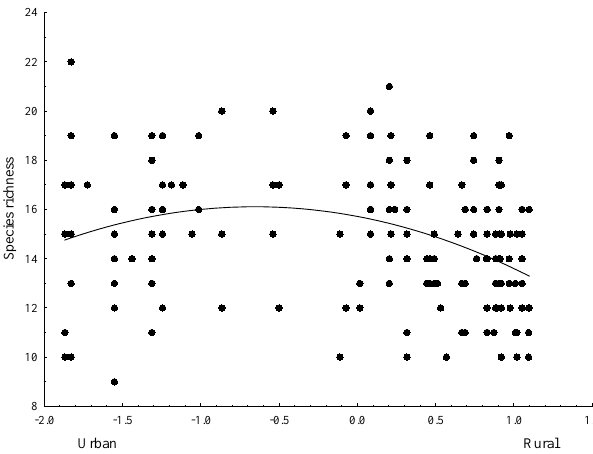
Figure 2. Non-linear principal component analysis regression showing the relationship between bird species richness (recorded at each point count station) and rural–urban gradient associated to the Factor 1 obtained from PCA. Best function fitting data distribution: y = 15 . 600 − 0 . 821 · x − 0 . 463 · x 2 . R = − 0 . 370; N = 182; p <